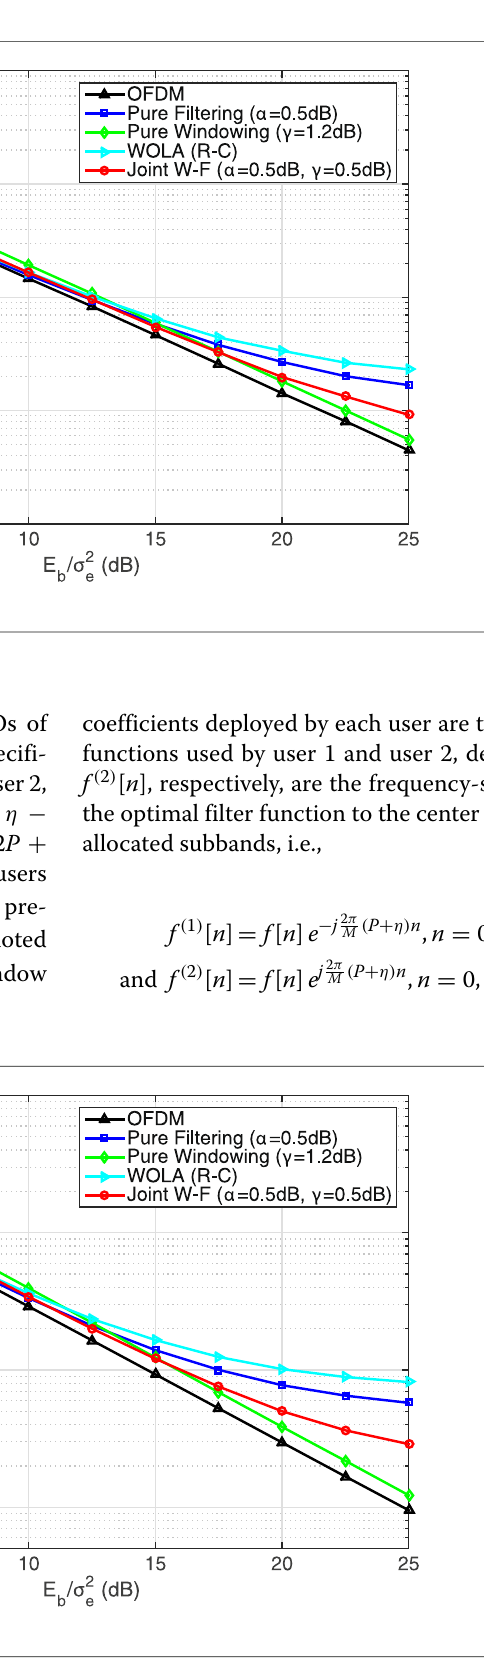
Fig. 11 ISI-incurring BER performances